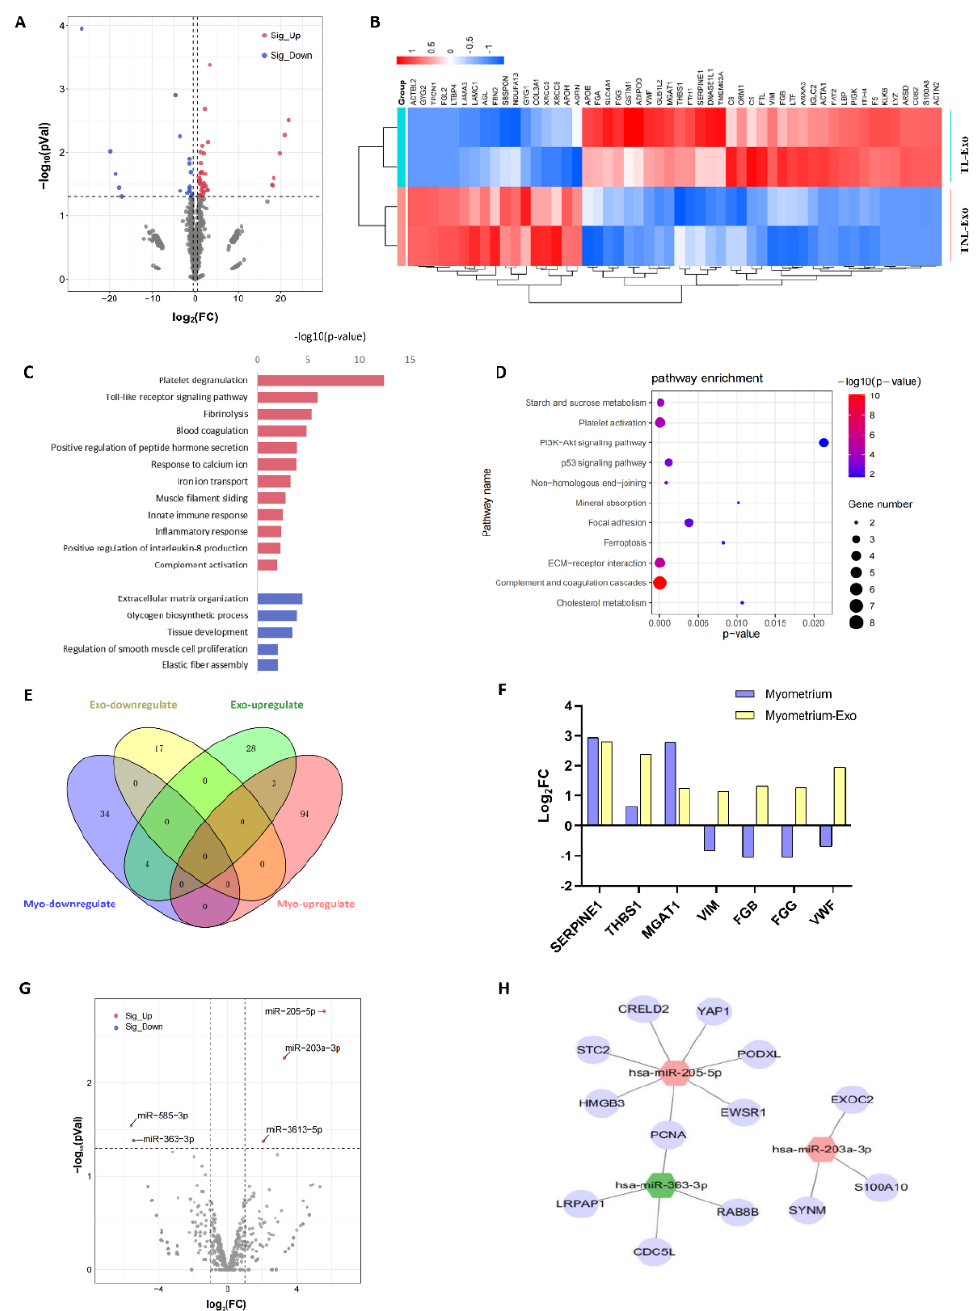
Figure 2. MicroRNA and proteomic profiles of exosomes in term non-labor and term labor myometrium. ( A ) Volcano plots for TNL ( n = 2) vs. TL ( n = 2) women. Significantly upregulated and downregulated proteins (adjusted p < 0.05) with a log 2 fold change (FC) ± 0.58 are represented by red and blue dots, respectively. Differentially expressed proteins that did not reach statistical significance are represented by gray dots. ( B ) Hierarchical clustering analysis of the screened DE proteins in the myometrium-derived exosome. ( C ) Bar diagram of the biology progress GO term clusters of DE proteins. ( D ) Bubble diagram of significantly enriched pathways for DE proteins. ( E ) Venn diagram of the DE gene set identified in exosome and tissue proteome. ( F ) Histogram of overlapping DE protein in the exosome and tissue. ( G ) Volcano plots for DE miRNAs of myometrial tissue exosomes in TNL and TL women. ( H ) Network of 2 upregulated miRNAs (hsa-miR-203a-3p and hsa-miR-205-5p) and 1 downregulated miRNA (hsa-miR-363-3p) and its target gene. Myo, myometrium.